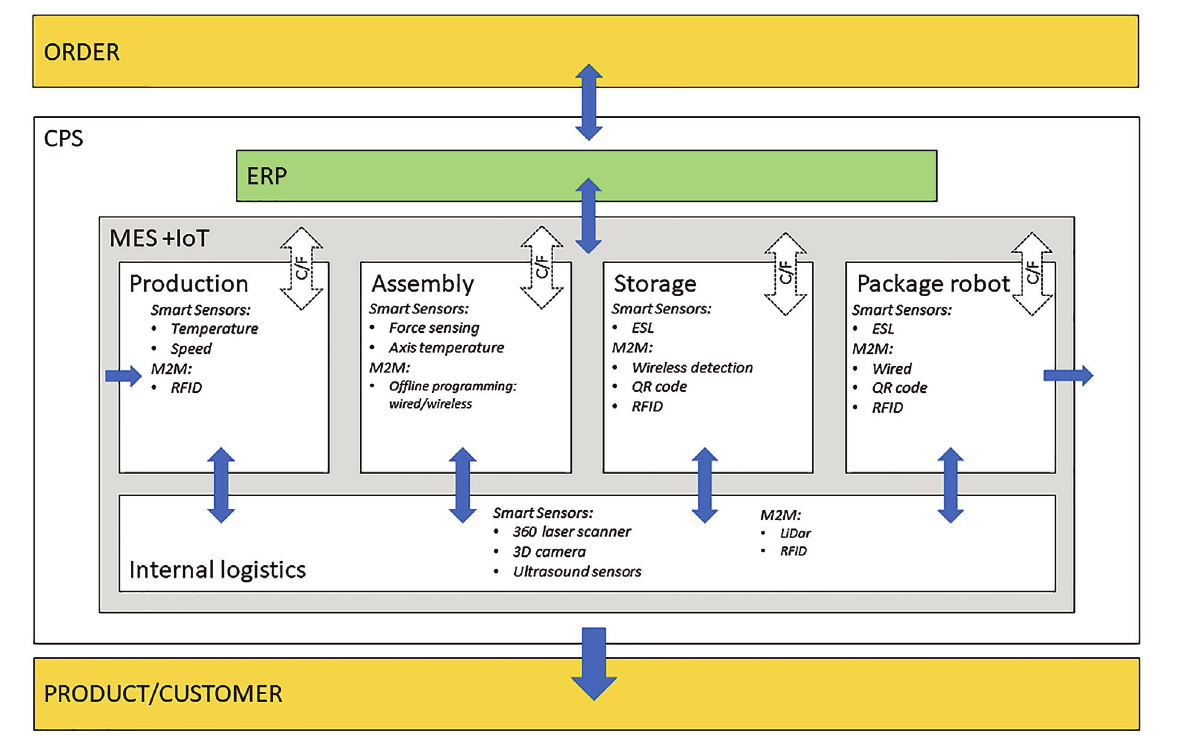
Fig. 5. Developed system ʼ s schematic diagram. ESL – Electronic Shelf Label; RFID – Radio Frequency